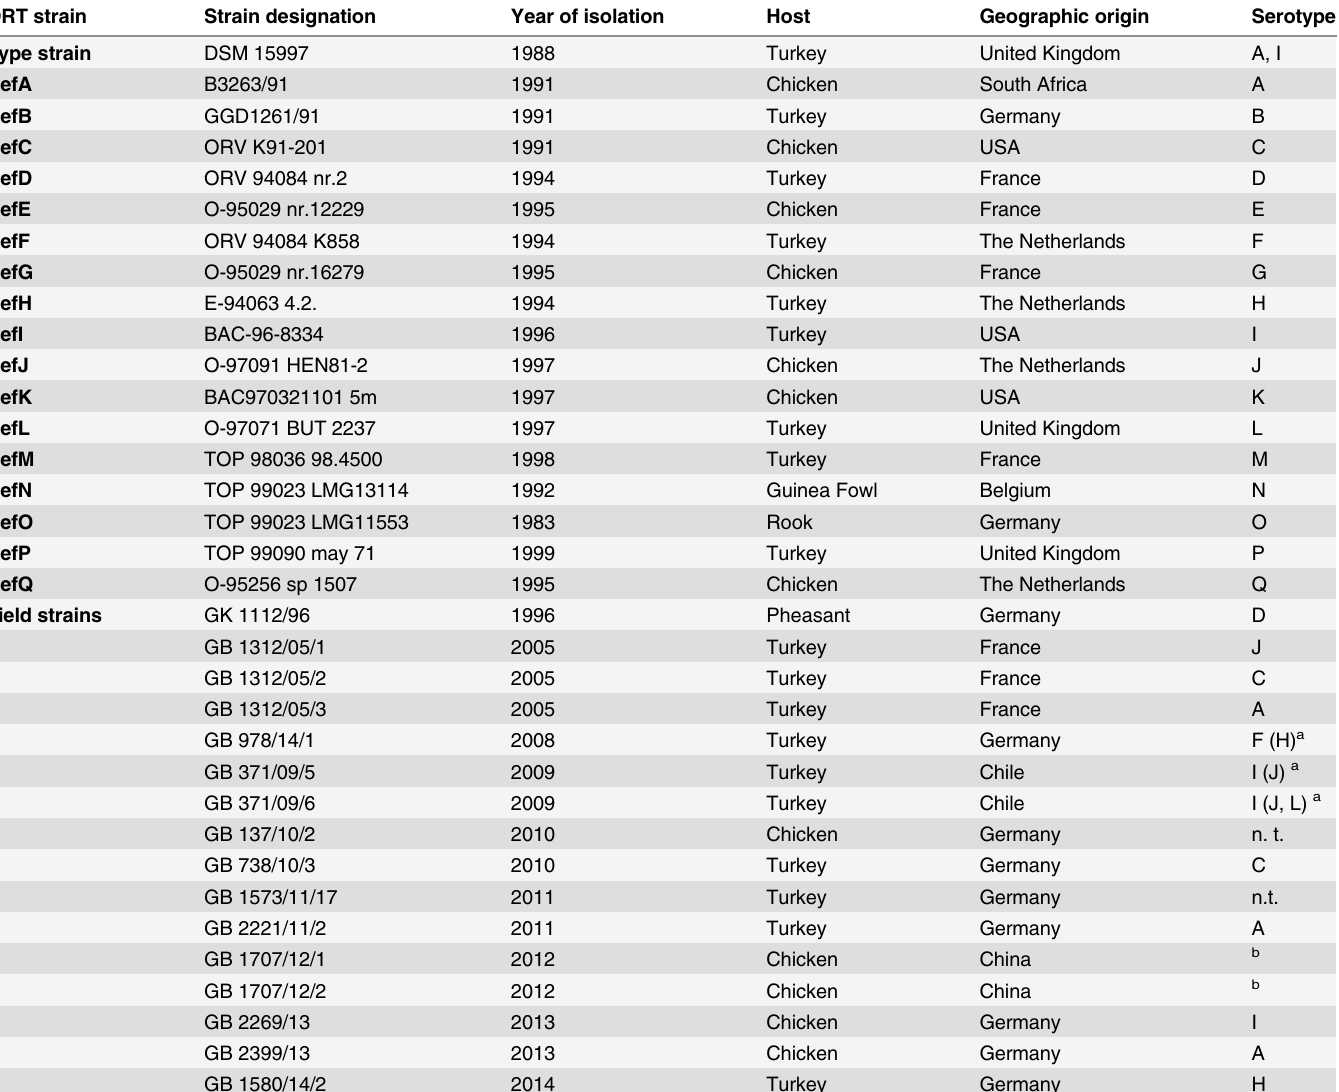
Table 1. Details of 34 representative strains used for multilocus sequence typing of Ornithobacterium rhinotracheale . ORT